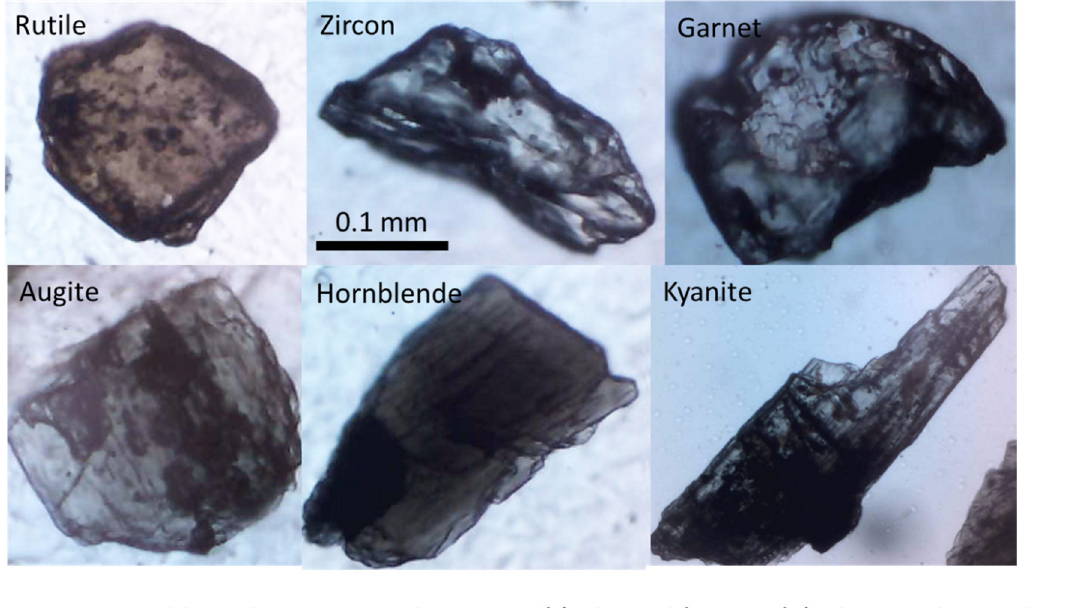
Figure 8. Representative heavy mineral assemblage from TSU-1 and TSU-2. Adapted from [19].